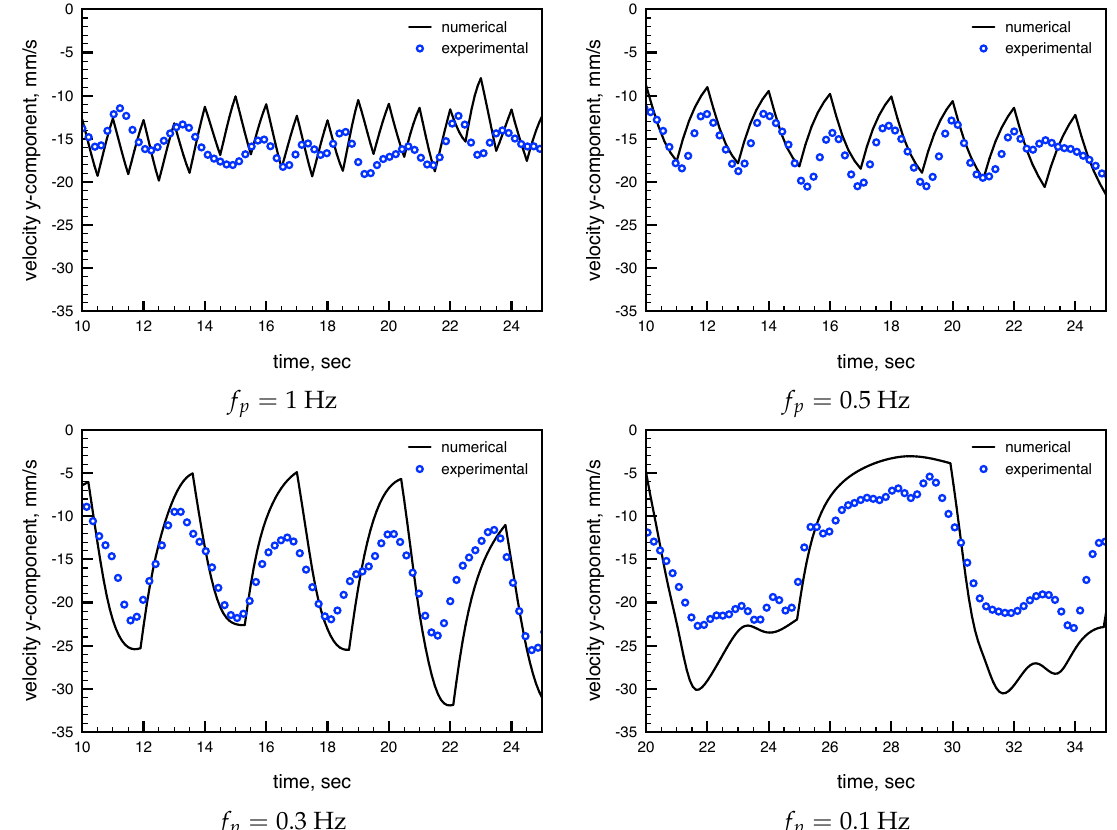
Figure 11. Comparison of experimentally (after FFT smooth) and numerically obtained velocities at different pulsation frequencies in near wall region. Animations of transient calculations can be found at supplementary data